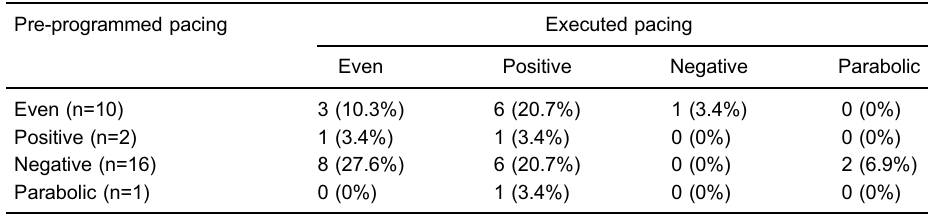
Table 1. Number and percentage of pre-programmed vs executed pacing.